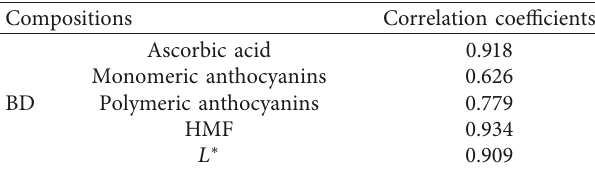
Table 3: Linear correlation coefficients between BD and non- enzymatic browning-related